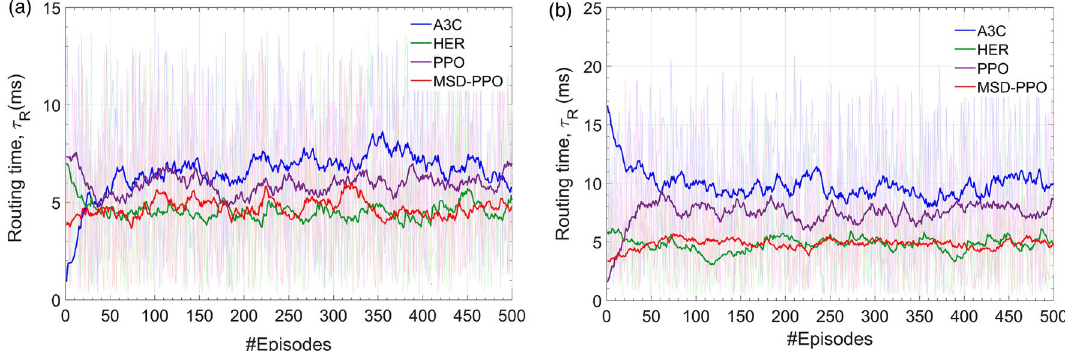
Figure 12. The smoothed total routing time of MSD and several reinforcement learning algorithms A3C, HER, PPO in 500 episode after finish the training process. (a) Results for environments without erroneous nodes. (b) Results for environments with erroneous nodes.